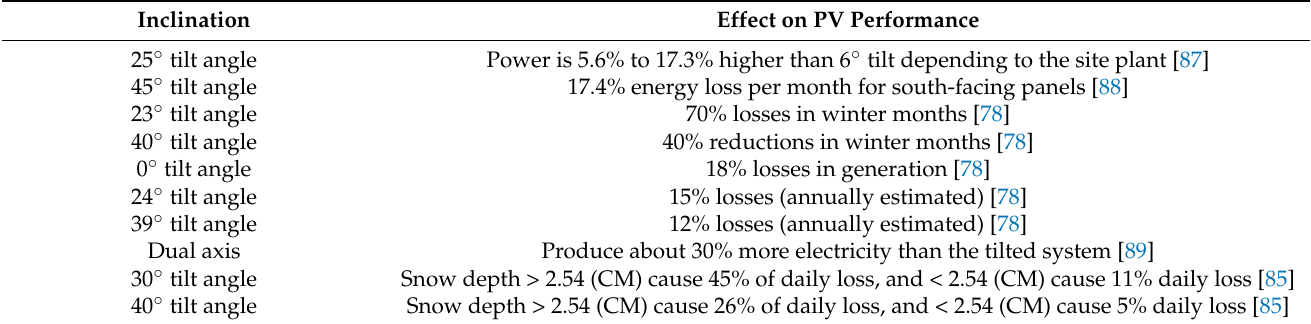
Table 4. The effects of inclinations on PV performances affecting the duration of shading, caused by snow-covered modules.